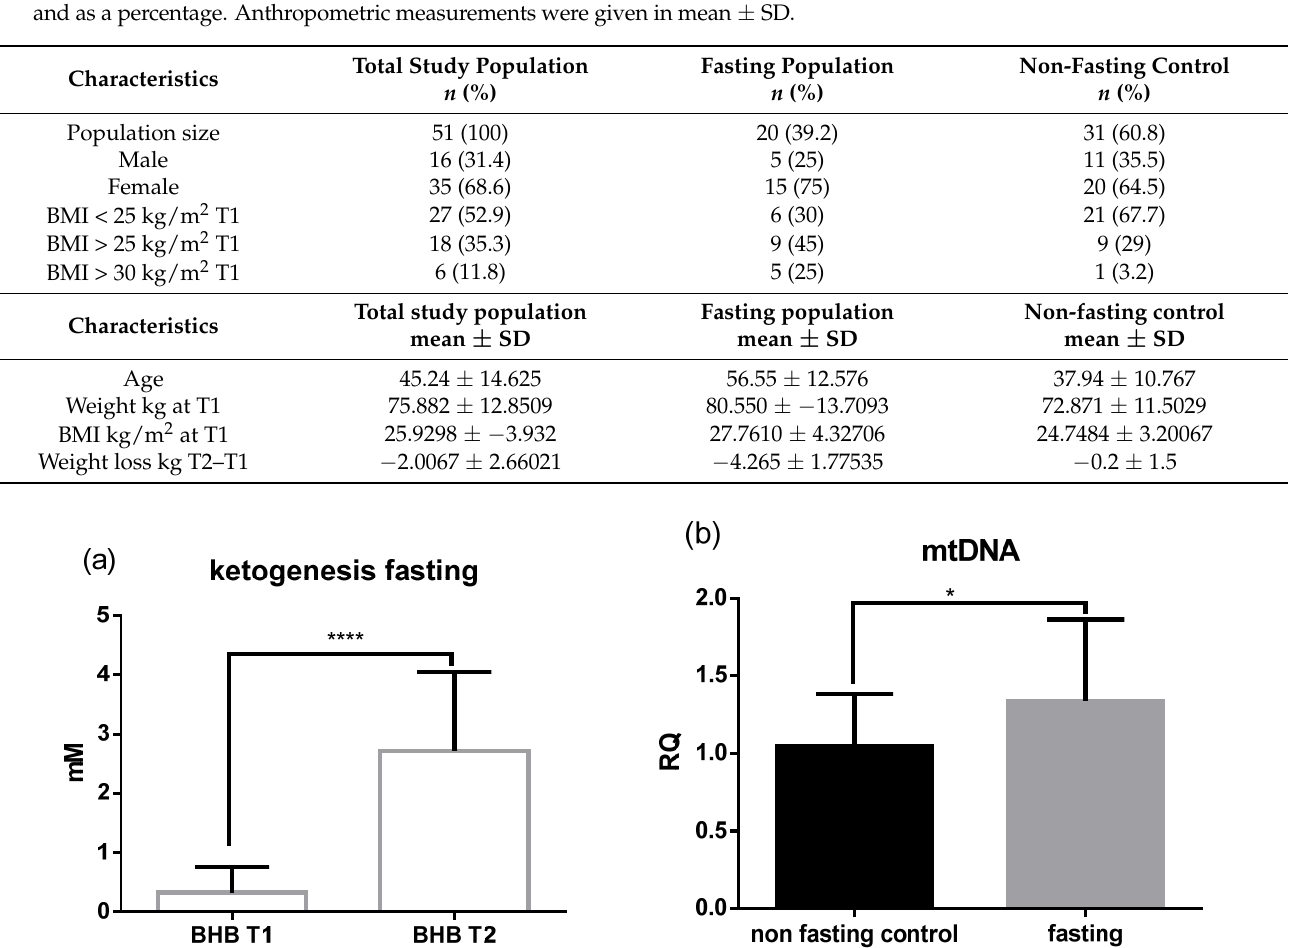
Figure 1. Periodic fasting (PF) increases ketogenesis and mitochondrial (mt)DNA. ( a ) ß-hydroxybutyrate (BHB) levels were measured in the blood of fasting subjects before (T1) and after (T2) the intervention ( p < 0.01). ( b ) Relative quantification (RQ) of mtDNA was measured in blood. The results are expressed as mean +/ − SD. Statistical significance was determined using paired t -test for parametric values and Wilcoxon test for nonparametric values.